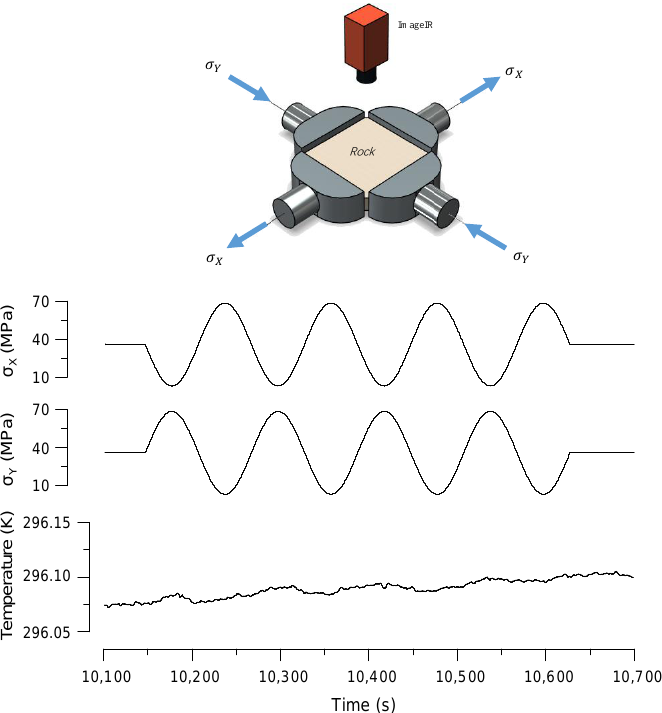
Figure 3. Variation in temperature during the biaxial test with out-of-phase loading on granite dio- rite.